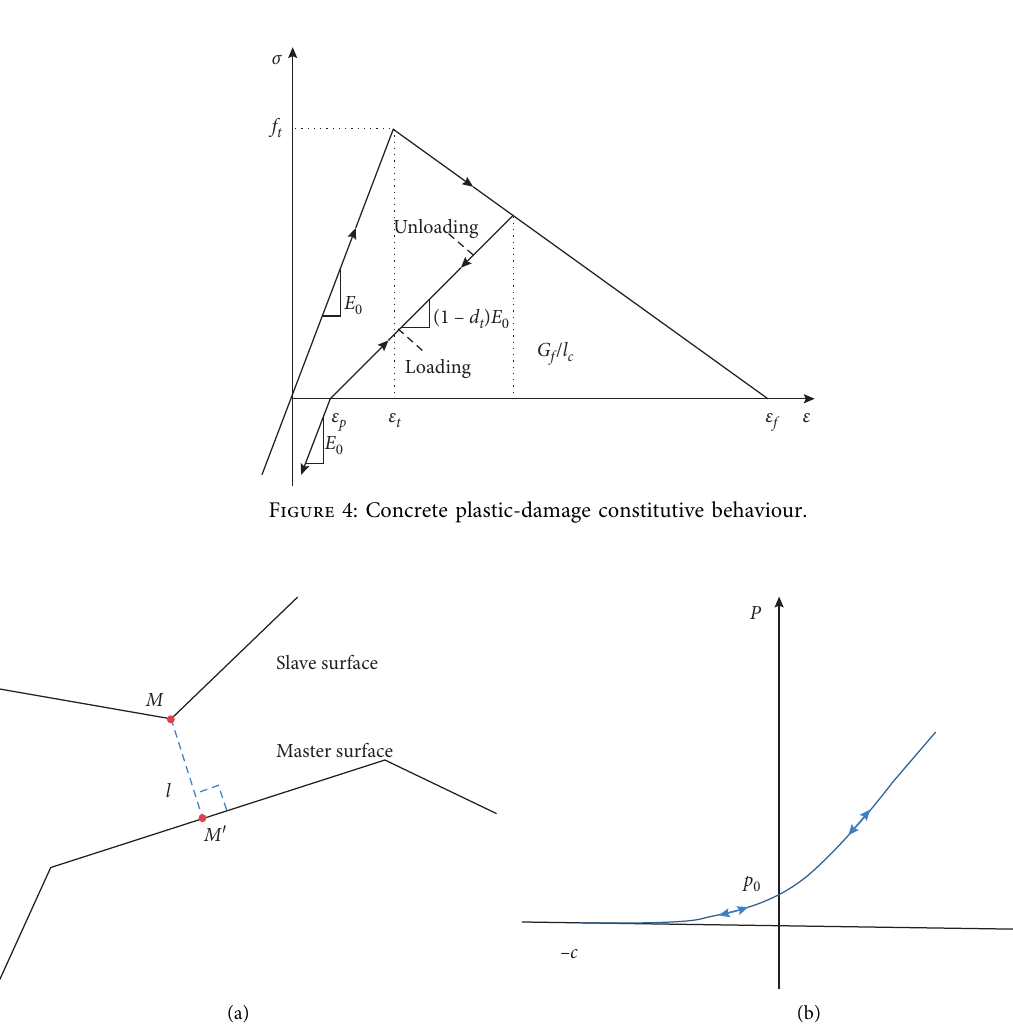
Figure 5: Contact boundary model for contraction joints: (a) relationship between elements of a contact pair; (b) pressure-overlap constitutive